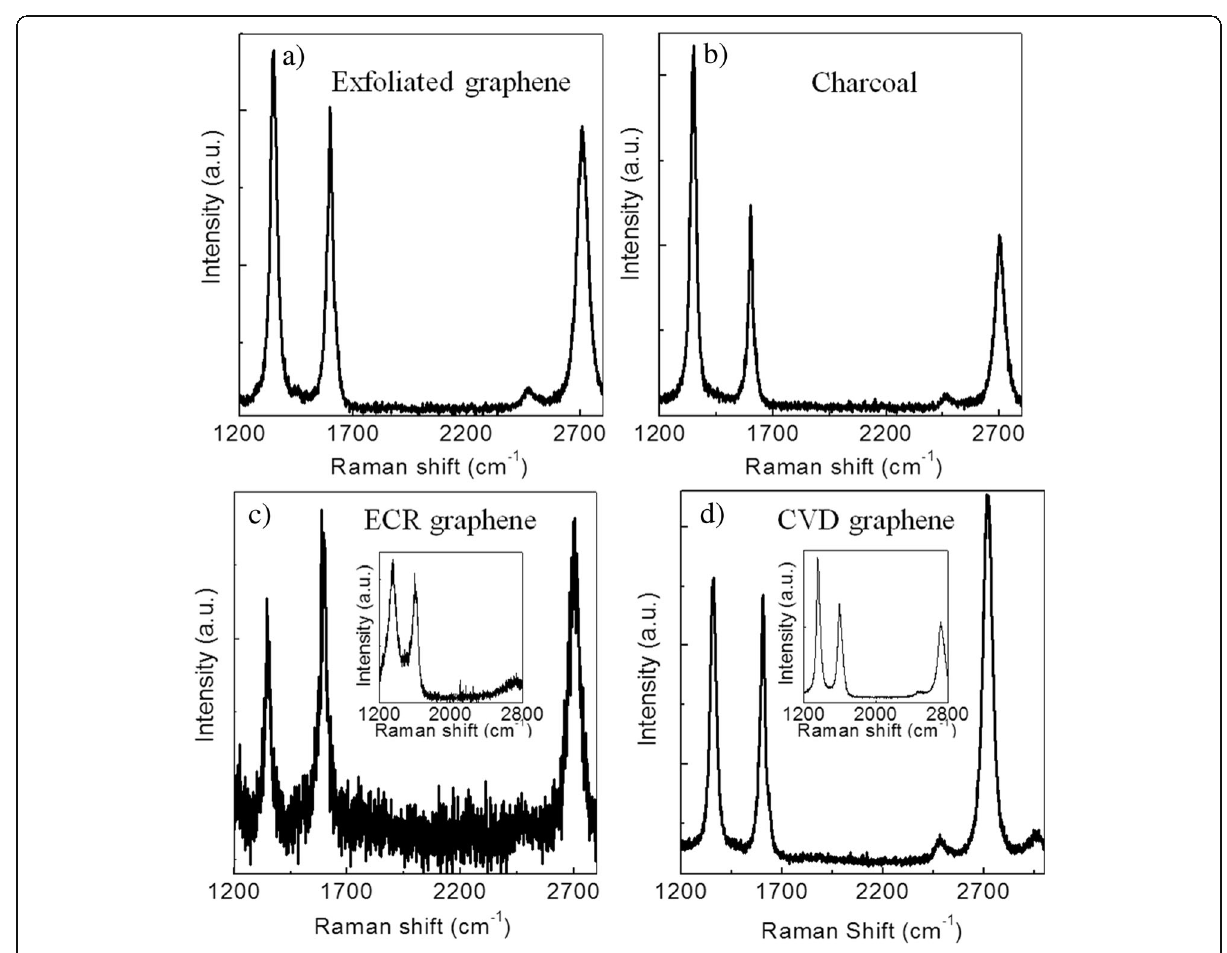
Fig. 5 Raman spectra of graphene grown by CVD for different seed materials including a mechanically exfoliated graphene, b charcoal, c ECR-CVD graphene, and d CVD graphene. The insets in Fig. 5c and d display the representative Raman spectrum of graphene seeds prepared by ECR-CVD and CVD route,